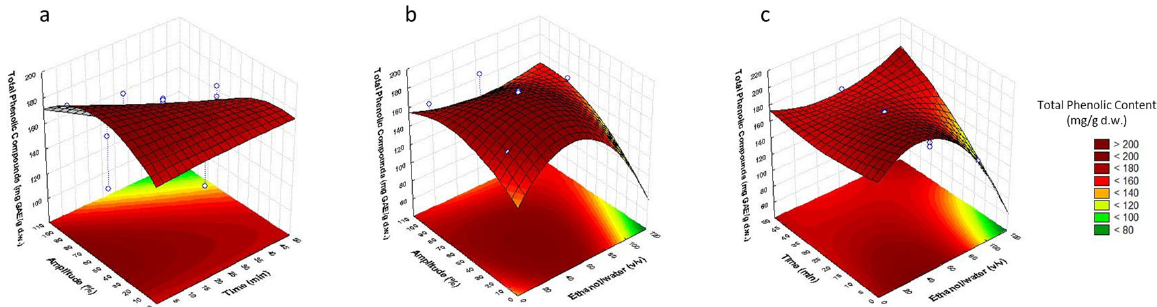
Figure 1. Response surface plots showing combined e ff ects of process variables for TPC (mg GAE/g d.w.): amplitude (%)—time (min) ( a ), amplitude (%)—% EtOH ( b ) and % EtOH—time (min) ( c